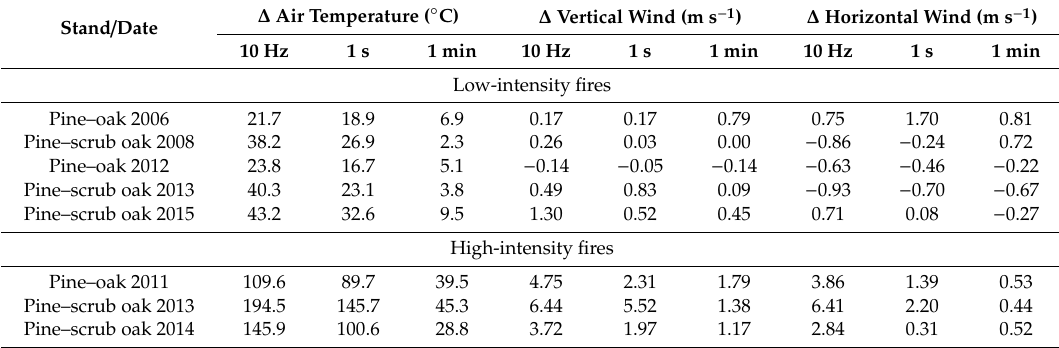
Table 4. Maximum di ff erences of above-canopy air temperature, vertical wind velocity, and horizontal wind velocity measured at 10 Hz and integrated over 1 s and 1 min averaging times on towers located in burned areas and control stands during the eight prescribed fires.